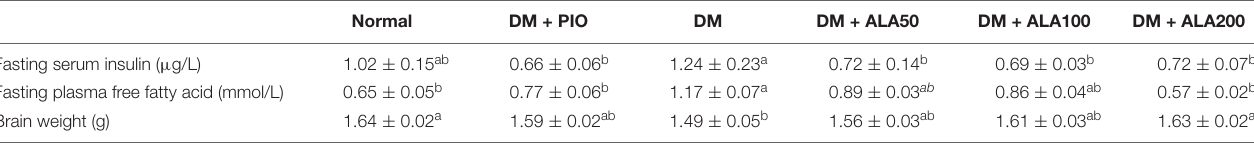
TABLE 1 | Profiles of fasting insulin, free fatty acid, and brain weight in high-fat diet and streptozotocin-induced type 2 diabetic rats treated with alpha-lipoic acid for 13 weeks.